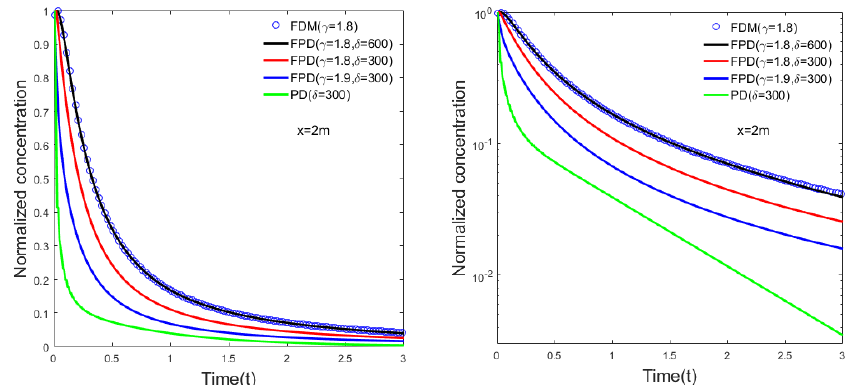
Figure 4. The normalized concentration profiles of PD with near-fields range δ = m ( ∆ x ) = 300, the FDM with space fractional index γ = 1.8, and the FPD models with different indexes and near-field ranges: γ = 1.8, δ = 300; γ = 1.8, δ = 600; γ = 1.9, δ = 300. Other model parameters were D α = 1.0, L = 2, and t = 3 s. The right plot is the semi − log form.